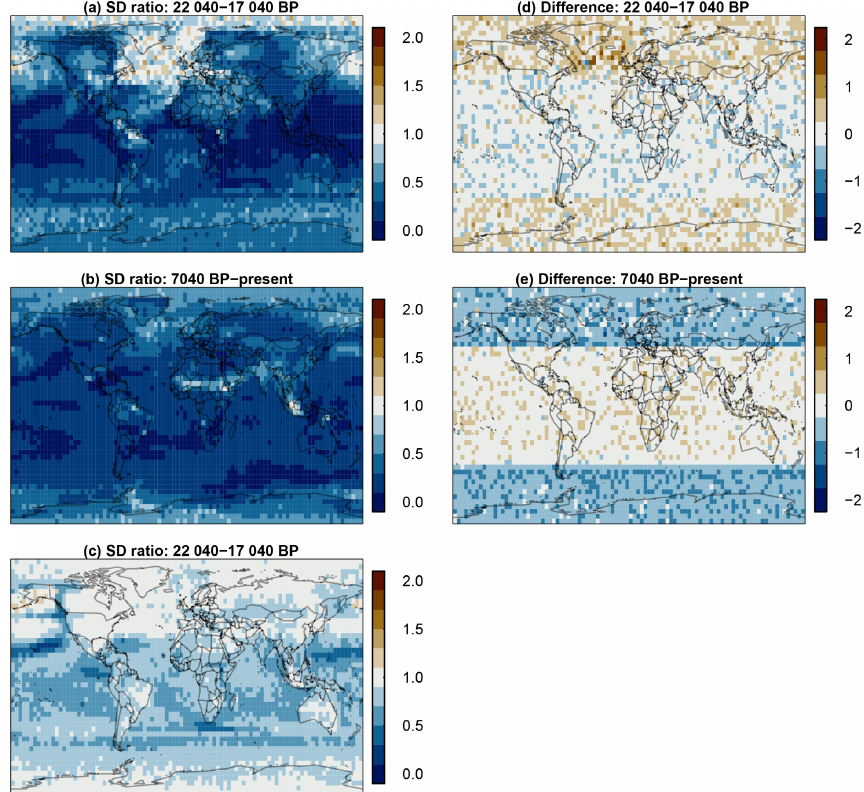
Figure 8. Left, standard deviation ratios of the sampled 501-year moving mean input data relative to the smoothed record plus AR(1) process and the effective dating error and the measurement noise for the samples in the first 5000 years of the record (a) , the last 7040 years of the record (b) , and the full record (c) . Right, differences between the mean of the sampled input data and the mean of the smoothed record plus AR(1) process and the effective dating error and the measurement noise for the samples in the first 5000 years of the record (d) and the last 7040 years of the record (e)